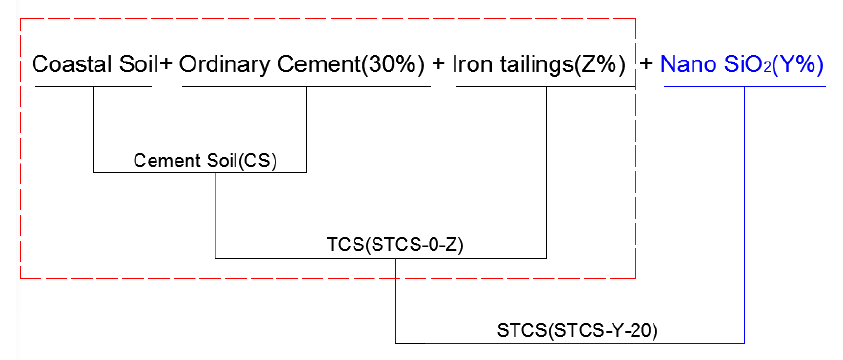
Figure 5. Material composition and specific symbols of the sample. Table 5. Test scheme for STCS.